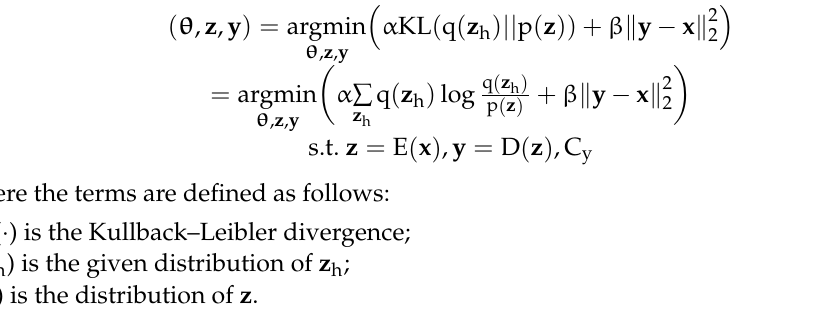
Figure 9. The architecture of classical variational auto-encoders.